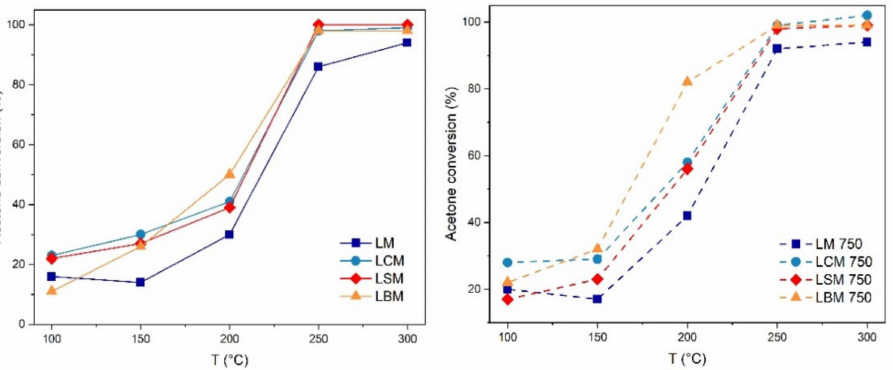
Figure 2. Acetone conversion vs. temperature curves for the LM, LCM, LSM and LBM as-prepared manganites and the LM750, LCM750, LSM750 and LBM750 calcined